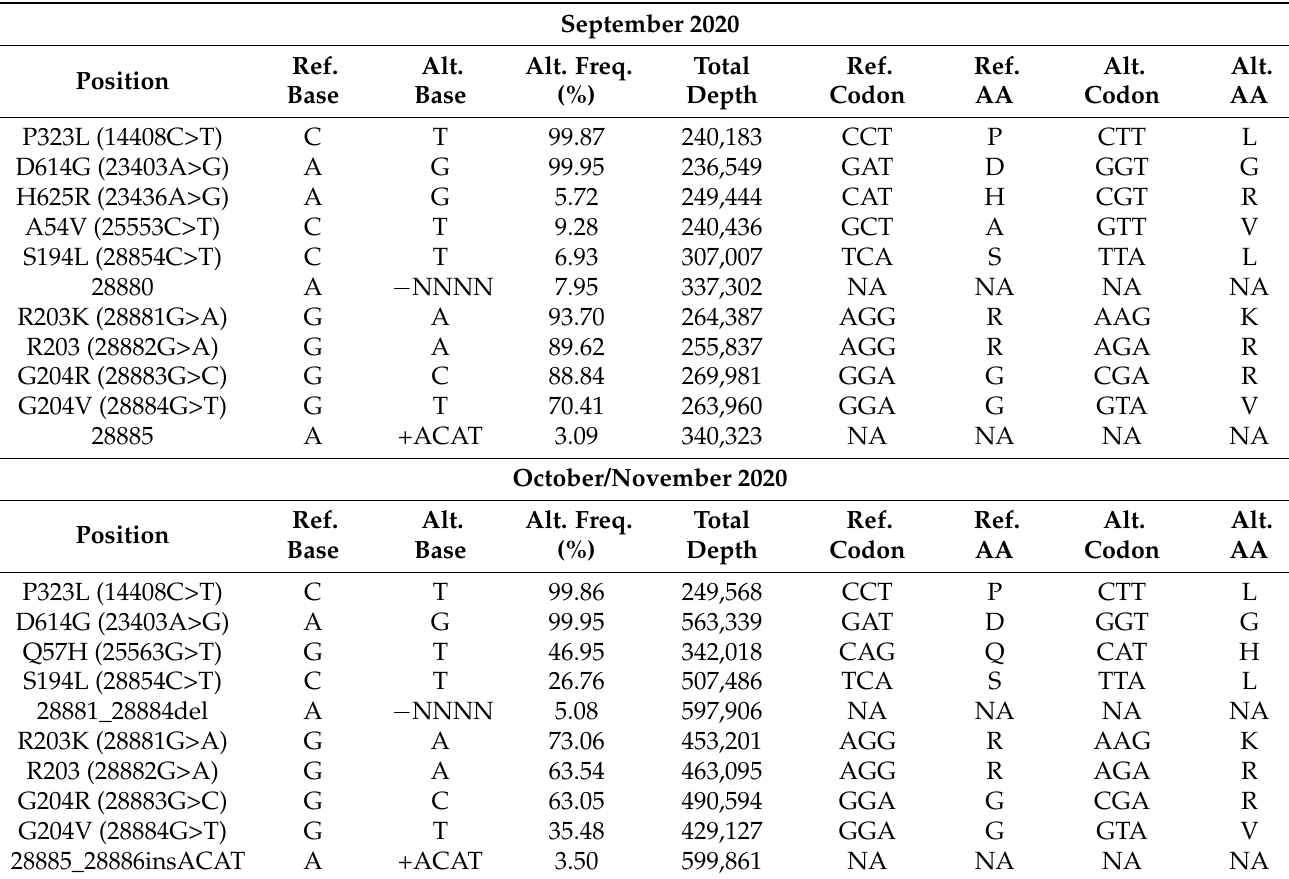
Table 2. Genomic variation profile (SNVs and indels) of SARS-CoV-2 by targeted